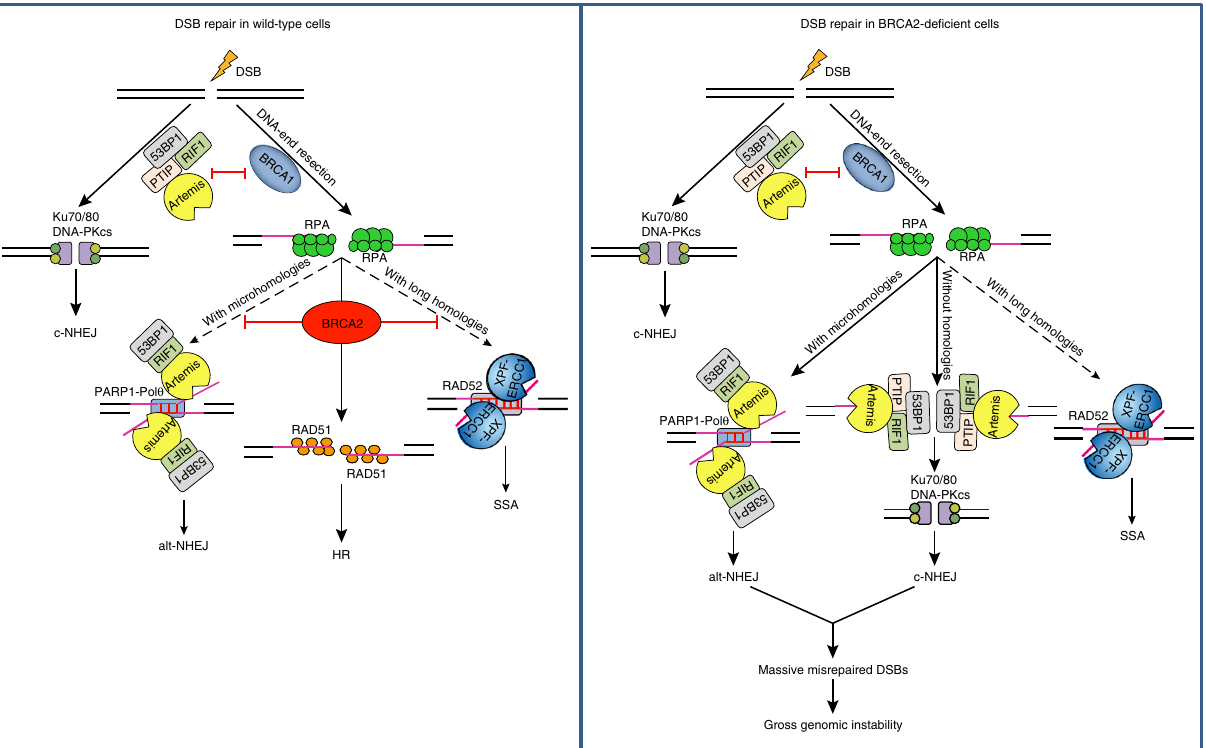
Fig. 8 A model showing the role of BRCA2 in maintaining genome